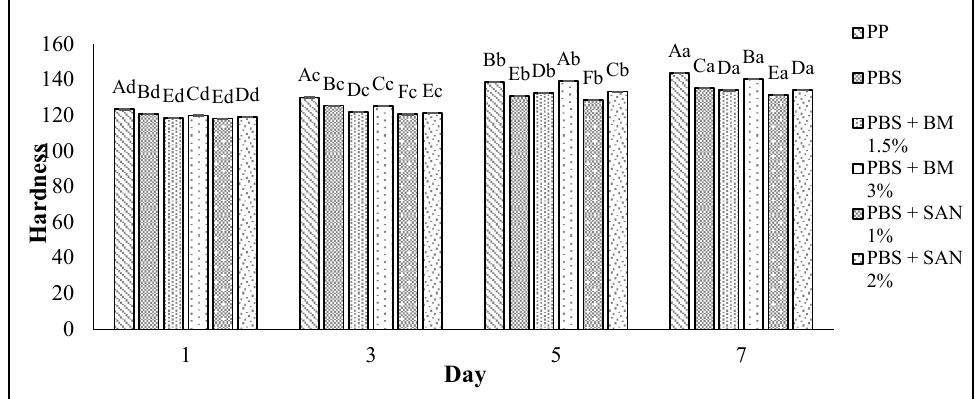
Figure 7. The hardness values of chicken breast fillets stored in PP container and PBS film laminated tray during storage at 4 °C for seven days. Note: PP: polypropylene microwavable container (control); PBS: PBS film (untreated); PBS + BM 1.5%: PBS film + 1.5% Biomaster silver; PBS + BM 3%: PBS film + 3% Biomaster silver; PBS + SAN 1%: PBS film + 1% SANAFOR; PBS + SAN 2%: PBS film + 2% SANAFOR. Error bars indicate standard deviation (n = 3). The different A–F capital letters are significantly different ( p < 0.05) among treatment for each day. The different a–d lowercase letters are significantly different ( p < 0.05) among storage day for each sample.